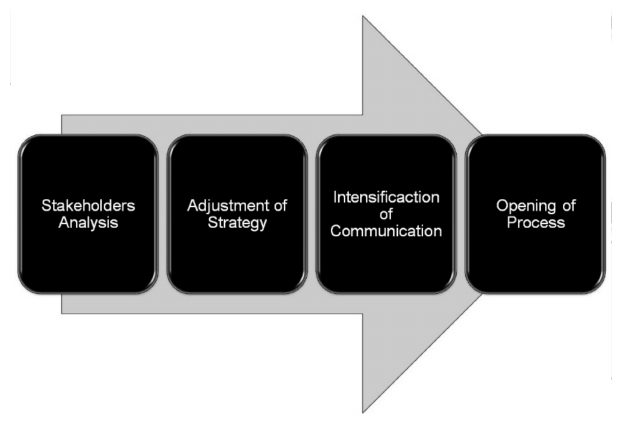
Figure 3. Stages in the diffusion